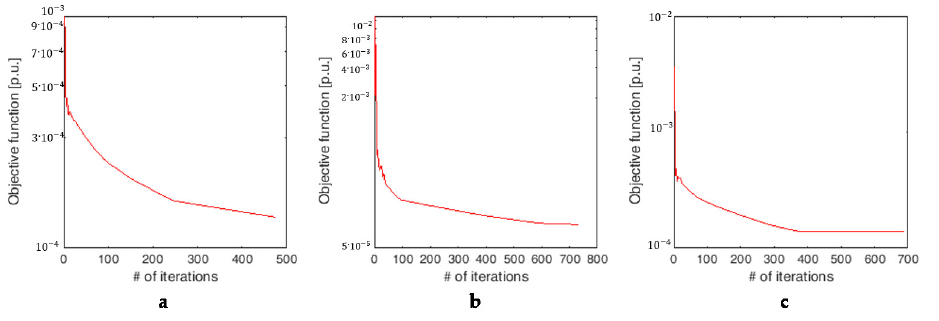
Figure 13. Objective function of the Decentralized APP for the partition in 7 VCZs: ( a ) Case 1, ( b ) Case 2, ( c ) Case 3.